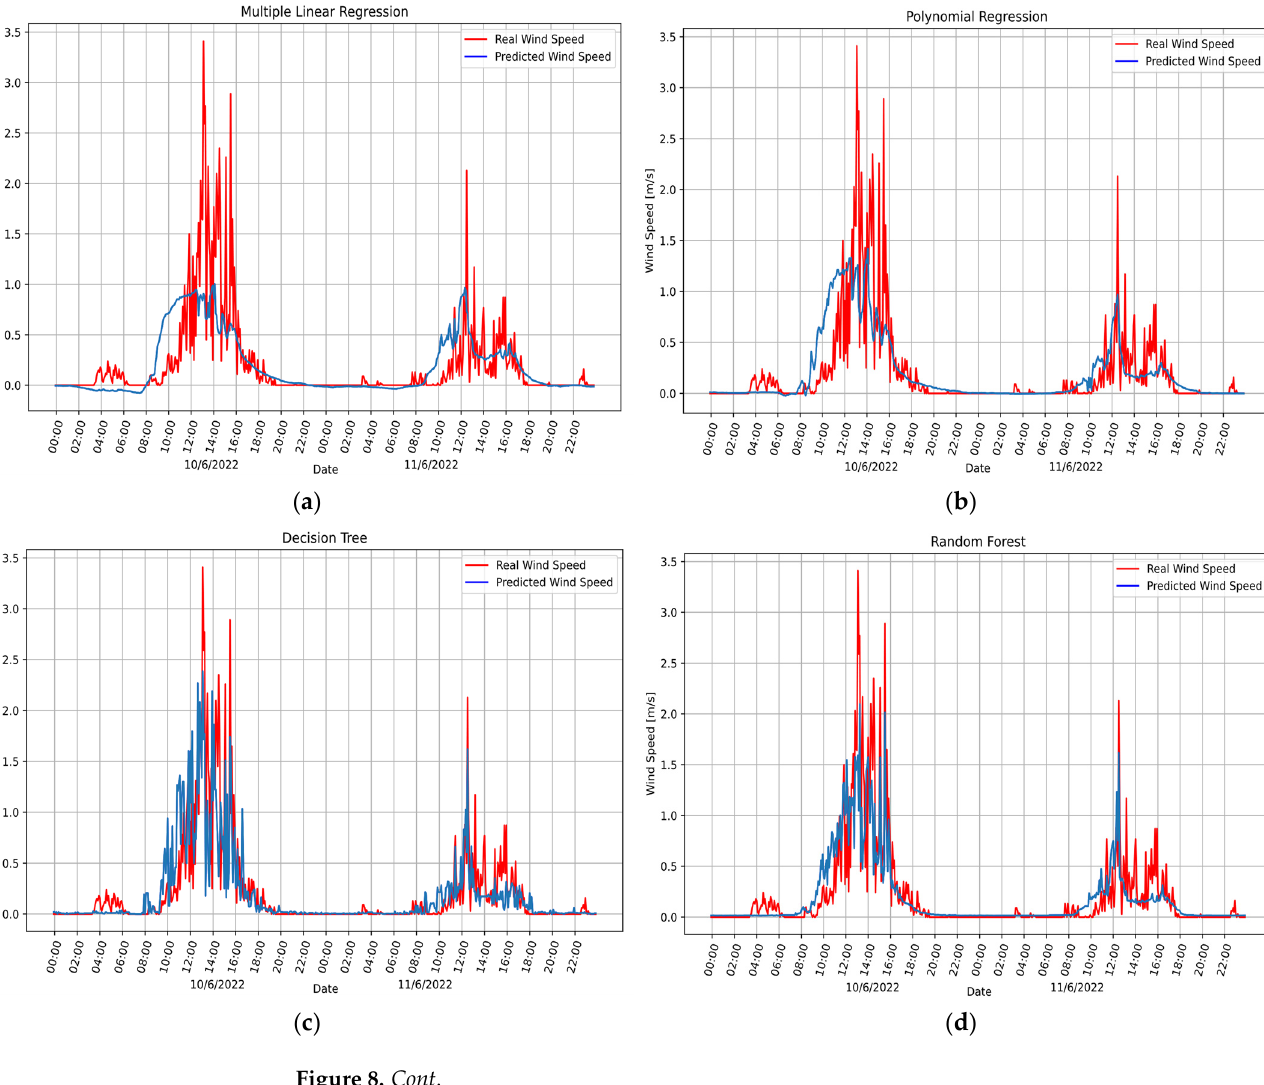
( f ) Figure 8. Techniques for wind speed forecast: ( a ) Multiple linear regression, ( b ) Polynomial regres- sion, ( c ) Decision tree, ( d ) Random forest, ( e ) XGboost, ( f ) Multilayer perceptron neural network.